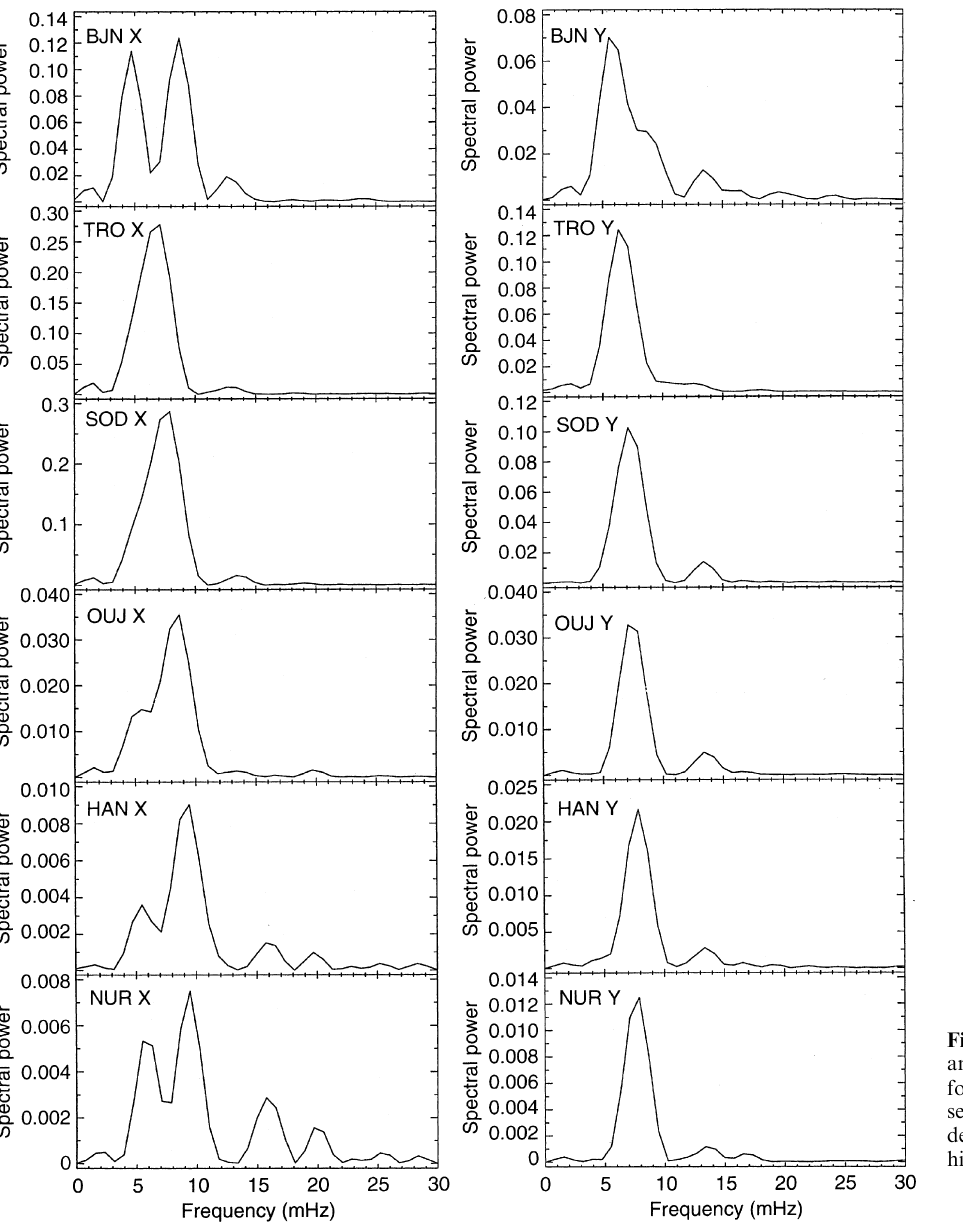
Fig. 4. Fourier power spectral analysis (linear arbitrary units) for the magnetometer data pre- sented in Fig. 3, in this case detrended with a 300 s (3.3 mHz) high